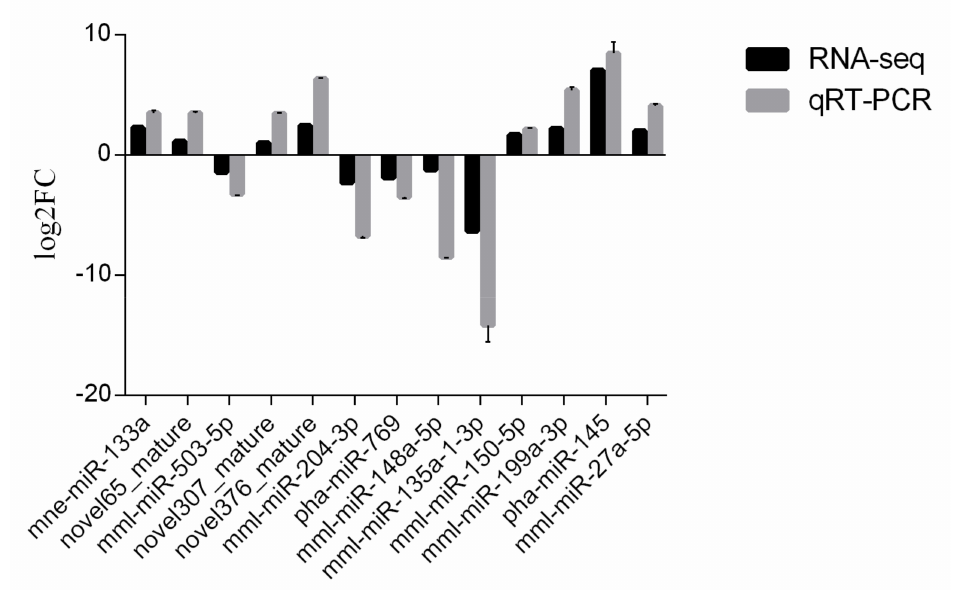
Figure 7. Validation of exosomal miRNAs’ expression by